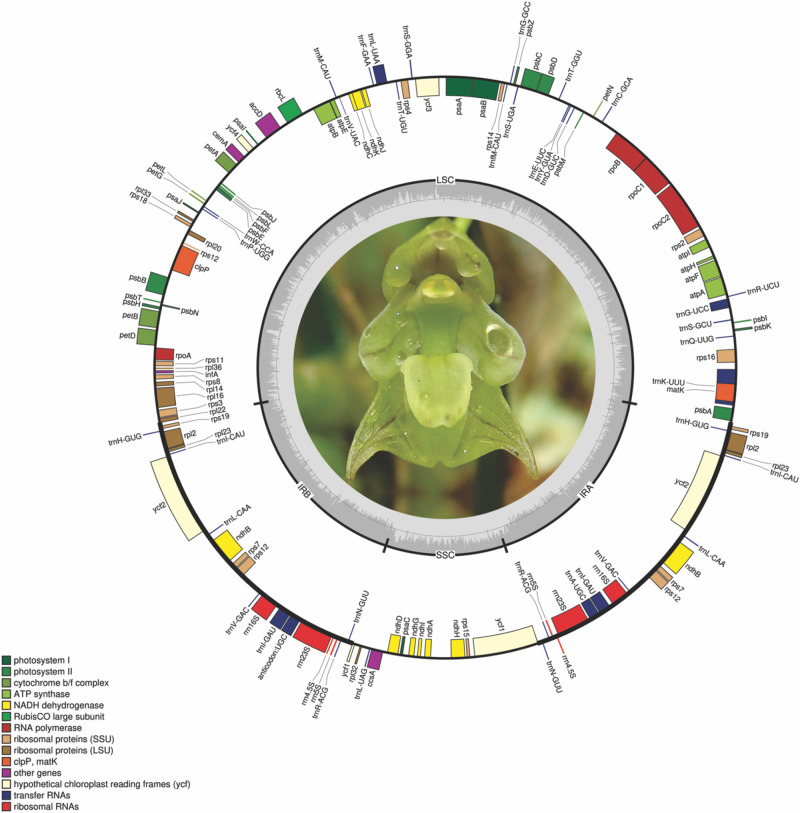
Bulbophyllum regnellii plastid genome. Genes shown on the outside of the circle are transcribed clockwise; genes on the inside are transcribed counterclockwise. The color of the gene boxes indicates the functional group to which the gene belongs. The thick lines indicate the length of the inverted repeats (IRA and IRB), separated by the large single-copy (LSC) and small single-copy (SSC) regions. The dashed darker gray area in the inner circle indicates genome GC content, whereas lighter gray area indicates AT content.